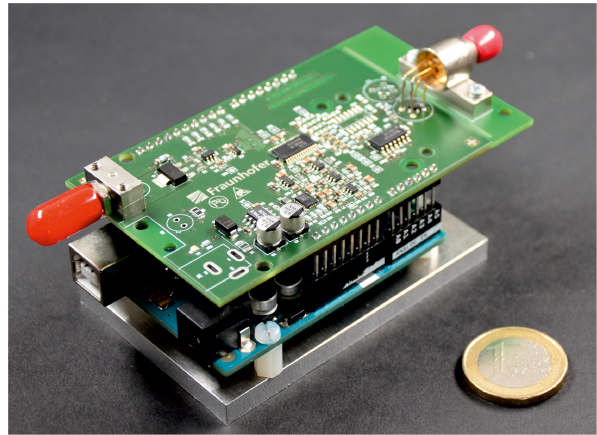
Figure 2. Photograph of the readout platform.